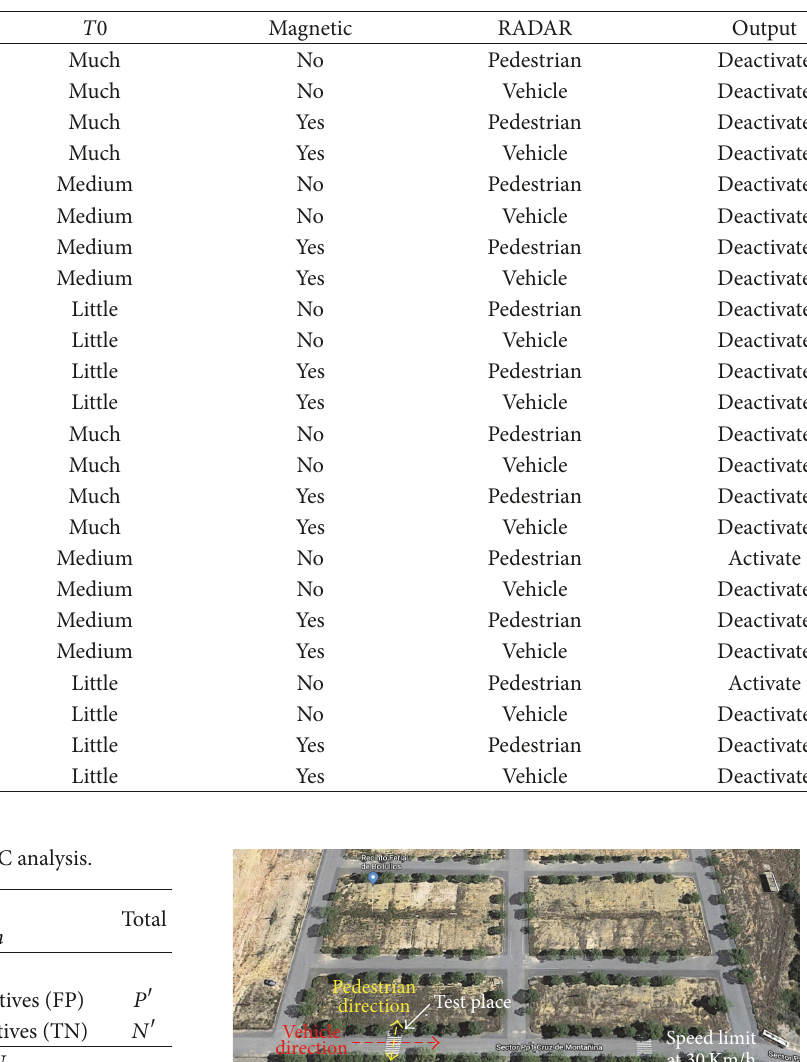
Table 6: Rule base for the whole sensory fusion controller.